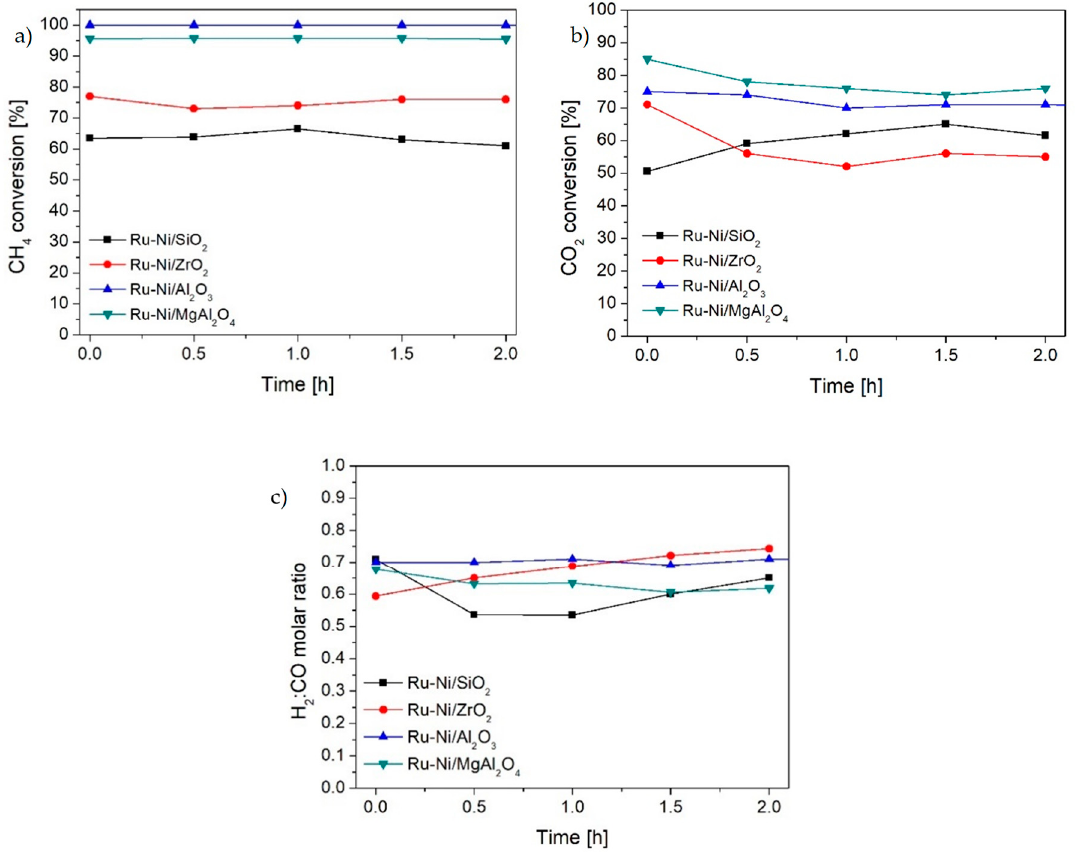
Figure 3. ( a ) Methane conversion, ( b ) carbon dioxide conversion, and ( c ) H 2 /CO molar ratio for ruthenium–nickel catalysts. ruthenium–nickel